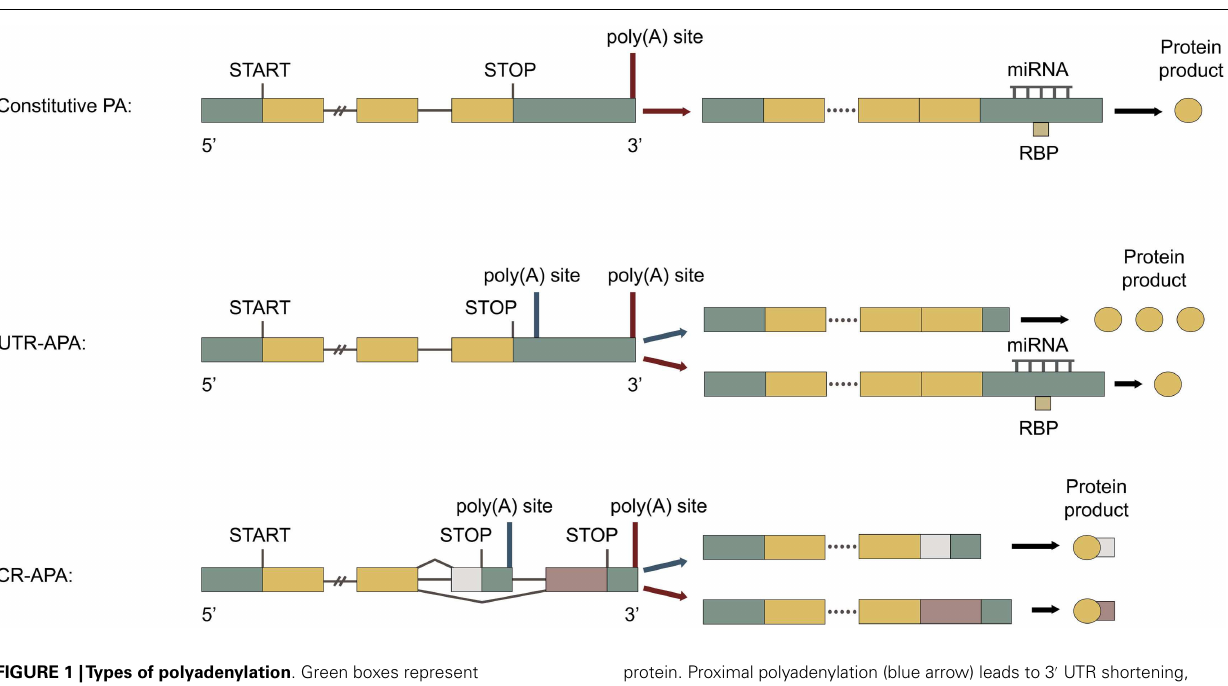
protein. Proximal polyadenylation (blue arrow) leads to 3 (cid:48) UTR shortening, less post-transcriptional regulation, and enhanced protein translation. Bottom: coding region (CR)-APA: gene contains additional poly(A) sites located in the CR of exons and in introns. APA results in mRNAs with different 3 (cid:48) UTRs and C-terminal CRs, producing distinct protein isoforms. Proximal polyadenylation (blue arrow) produces a mRNA with a different C-terminal CR and 3 (cid:48) UTR, producing a C-terminally truncated protein